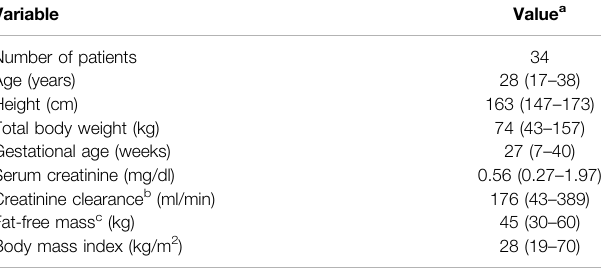
TABLE 1 | Patient demographics and baseline